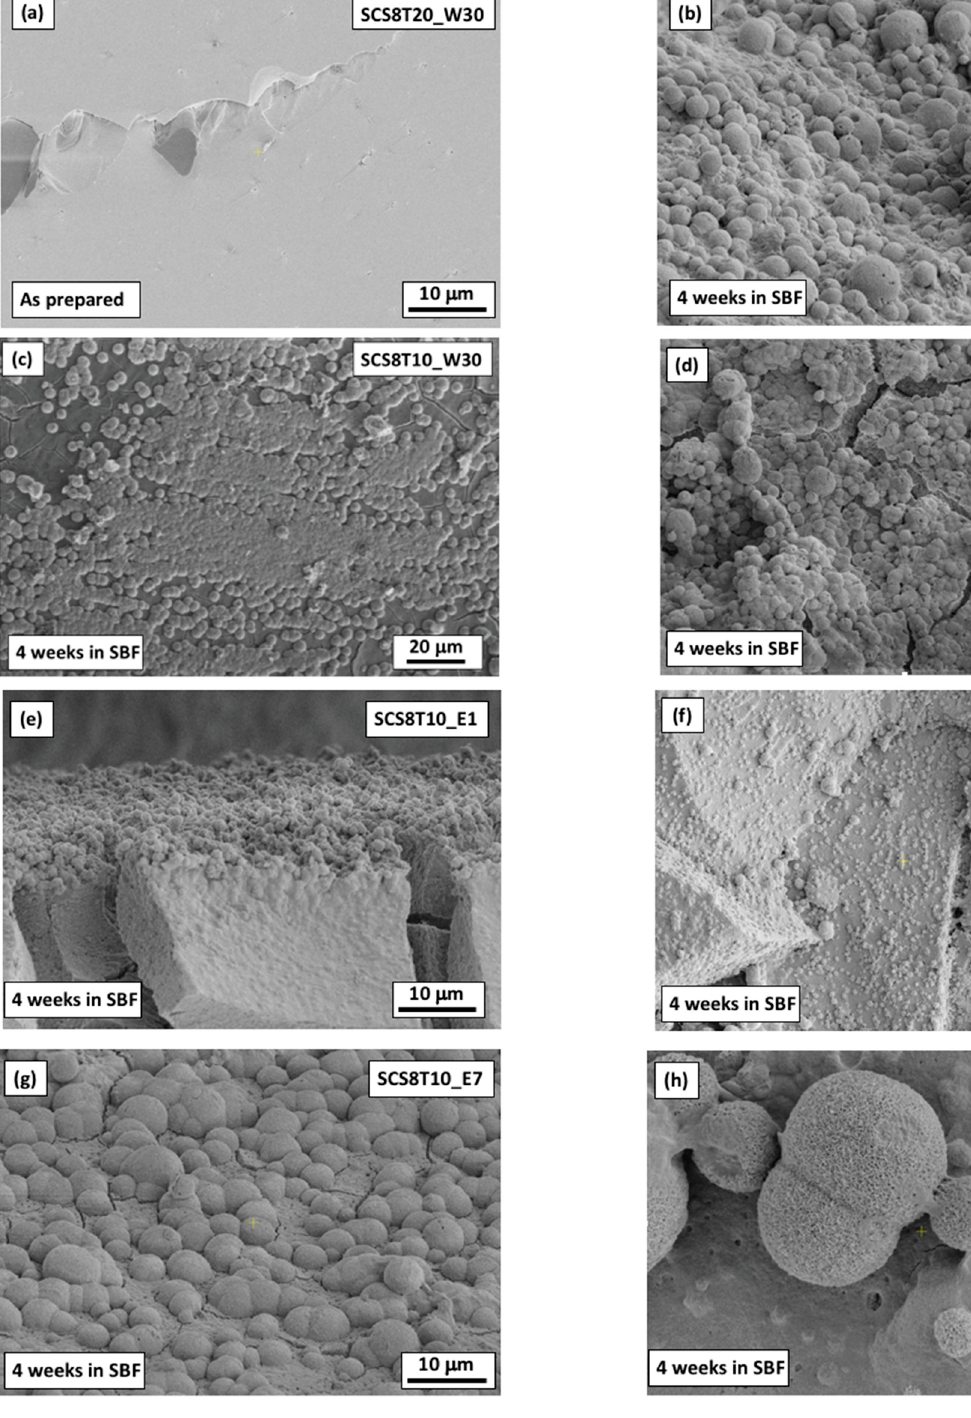
Figure 7. SEM micrographs of the apatite layer formed after 4 weeks soaking in SBF: ( a ) control (as prepared SCS8T20_W30 xerogel); ( b ) apatite layer on SCS8_W30; ( c ) different size crystals of apatite covering the surfaces of SCS8T10_W30; ( d ) SCS8T20_W30; ( e ) layer of homogenous apatite on SCS8T10_E1; ( f ) apatite crystals of different size growing and covering the surface of SCS8T20_E1; ( g ) apatite homogenous layer on SCS8T10_E7; ( h ) spherulites with different size and nucleation process of apatite from the surface of SCS8T20_E7 xerogel.